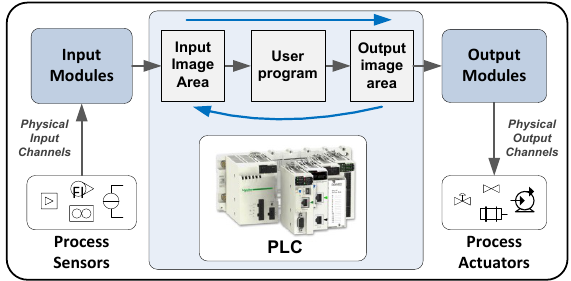
Figure 10. PLC scan cycle.